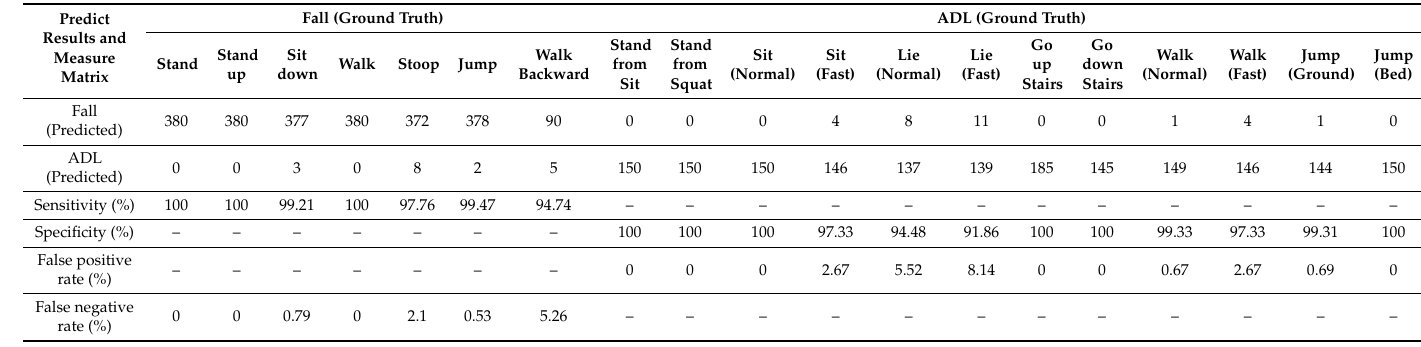
Table 7. The confusion matrix of the machine learning–based algorithm for each fall and ADL. The number of falls and ADLs is the total number of five-fold cross-validations over five